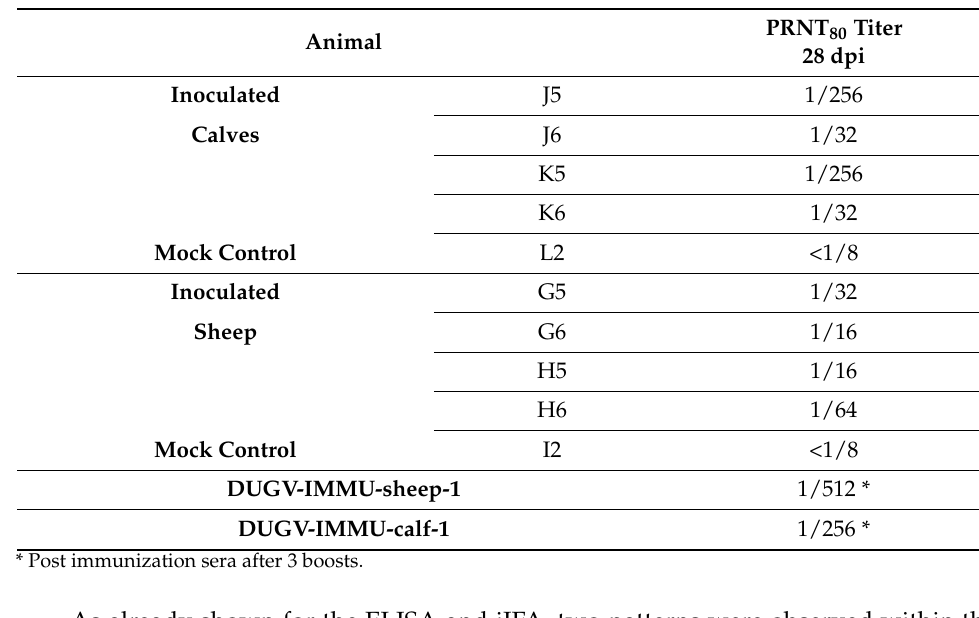
Table 3. PRNT 80 titers of inoculated and immunized animals.